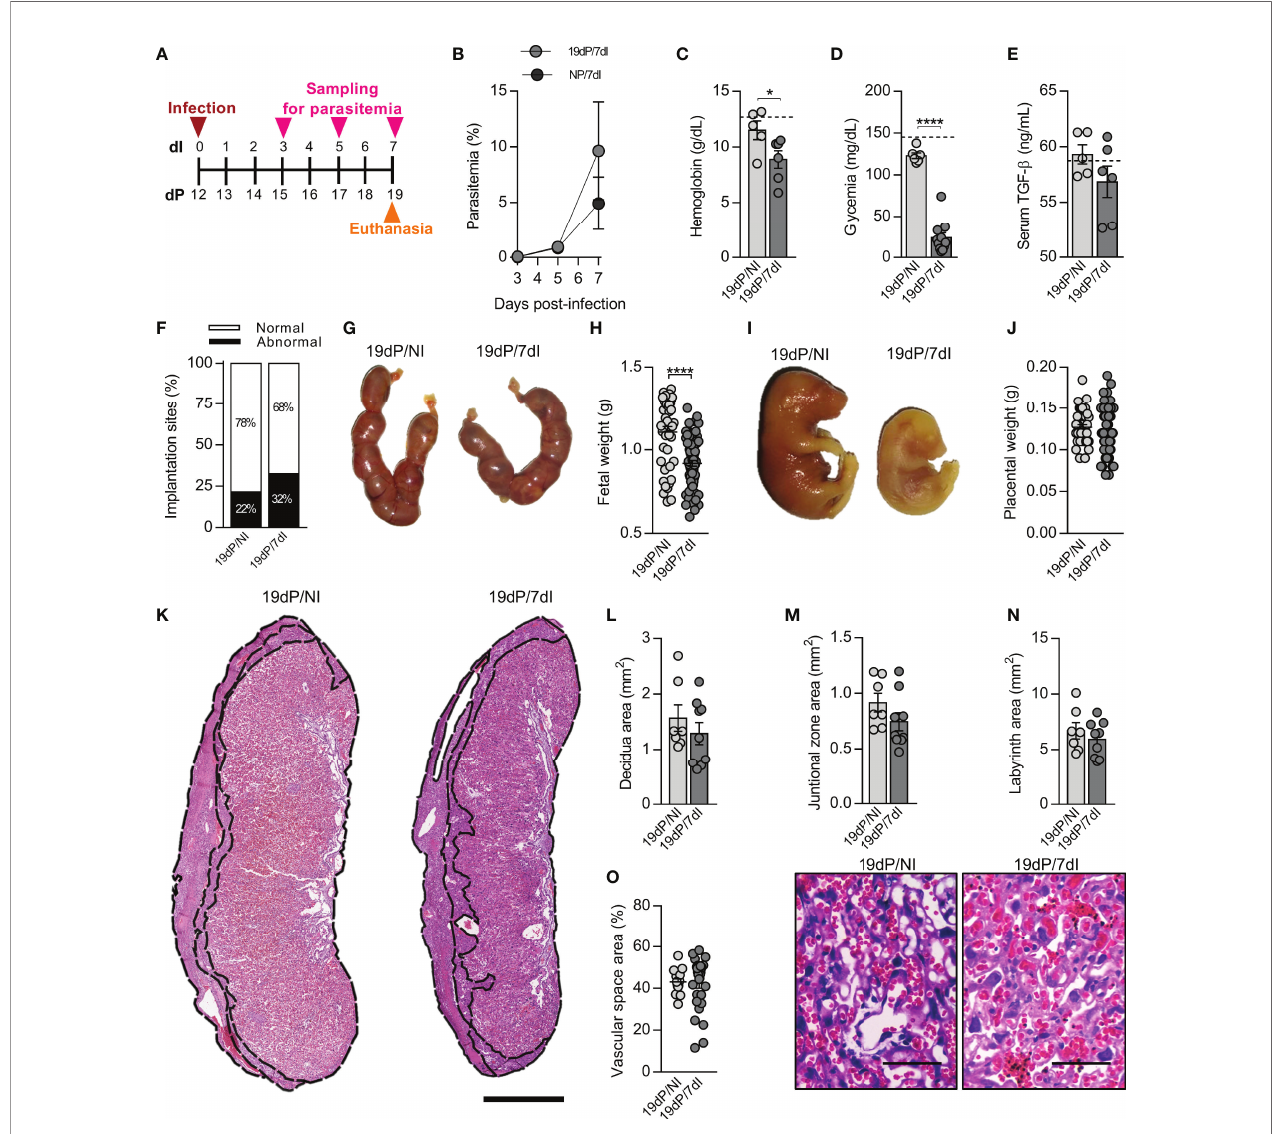
FIGURE 3 | Malaria impairs maternal and fetal outcomes in late pregnancy. (A) An experimental design for the study of malaria in late gestation using BALB/c mice infected with P. berghei ANKA was performed. (B) Parasitemia levels were estimated by fl ow cytometry (n = 5 mice/group). (C – E) Hemoglobin (19dP/NI, n=5; 19dP/7dI, n=6), blood glucose (19dP/NI, n=6; 19dP/7dI, n=11) and serum TGF- b levels (19dP/NI, n=5; 19dP/7dI, n=6) were measured. The dashed lines indicate the mean results of non-pregnant uninfected mice for each parameter evaluated. (F, G) The implantations sites were classi fi ed as normal or abnormal (F) according to macroscopic aspect (19dP/NI, n=7; 19dP/7dI, n=11) (G) . (H – J) Fetal and placental weight were recorded. Each point represents the measurement of a placenta or fetus (19dP/NI, n=42 fetuses/placentas derived from 7 litters; 19dP/7dI, n= 77 fetuses/placentas derived from 11 litters). (K – N) Placental sections were stained by H&E (K) for delimitation of decidua (L) , junctional zone (M) and labyrinth (N) layers (19dP/ NI, n=7; 19dP/7dI, n=9), scale bar 1 mm. (O) Vascular space area in labyrinth layer was estimated in placenta sections stained with H&E (19dP/NI, n=16 placentas derived from 7 litters; 19dP/7dI, n=29 placentas derived from 11 litters), scale bar 50 m m. Results represent mean ± SEM. Data was analyzed by Two-way ANOVA followed by Bonferroni ’ s